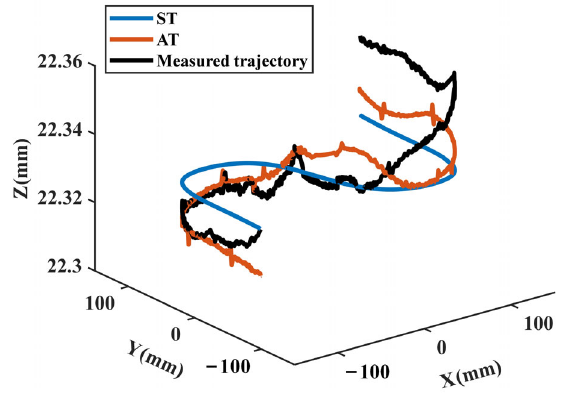
Figure 20. The ST, AT, and MT.